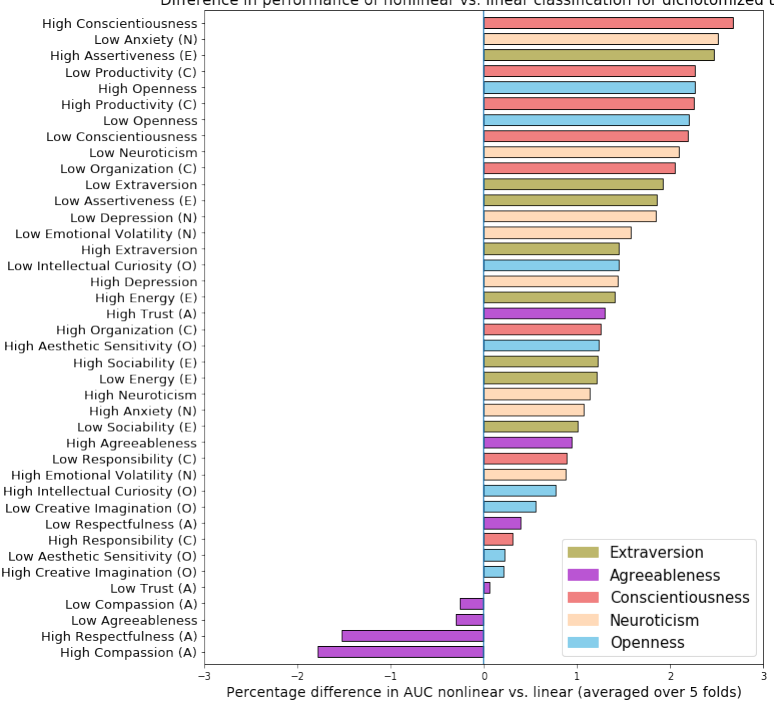
Figure A3. Percentage difference in predictive accuracy of nonlinear vs. linear classification models for dichotomized personality traits, expressed by the difference in Area under the Curve (AUC), and ranked by decreasing difference in AUC. Positive values indicate that the best nonlinear model outperformed the best linear model.